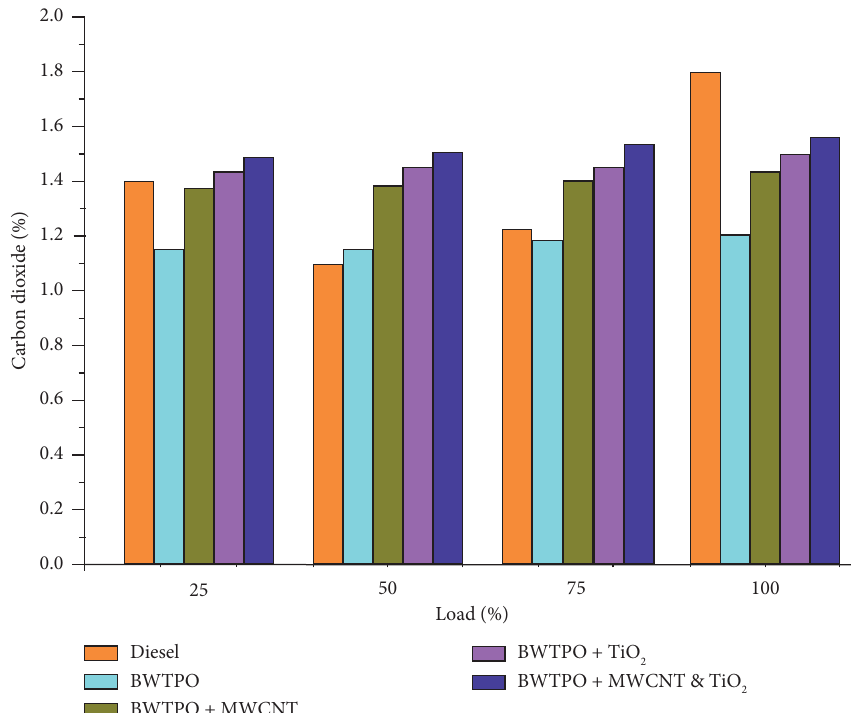
Figure 9: Relationship between carbon dioxide emissions (%) and load variations (%).